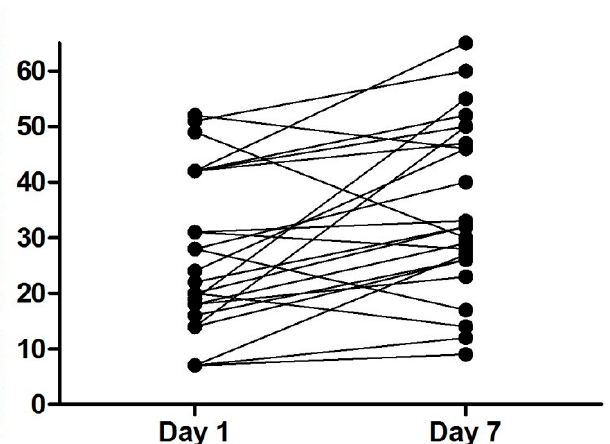
Figure 1. Number of shuttles performed at the 20 m shuttle run test (20mSRT) by each subject (black dot) on the first (Day 1) and last day (Day 7) of a summer asthma camp at low altitude (900 m) in the Italian Alps. Mean number of shuttles performed was 26.6 ± 14.6 at day 1 and 33.7 ± 14.9 at day 7 ( p < 0.001).